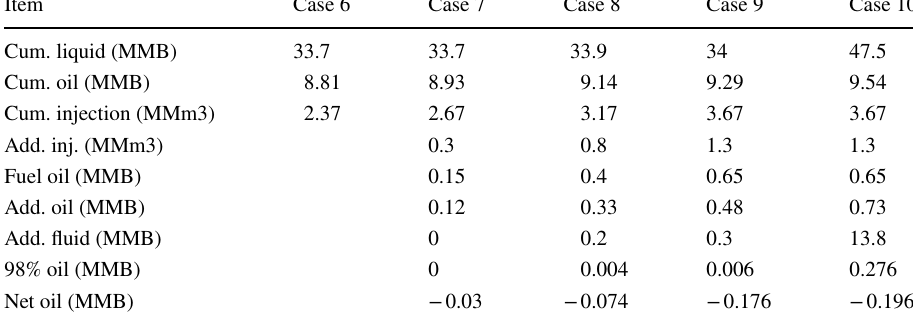
Table 9 Liquid rate and injection rate of each well in selected ten cases